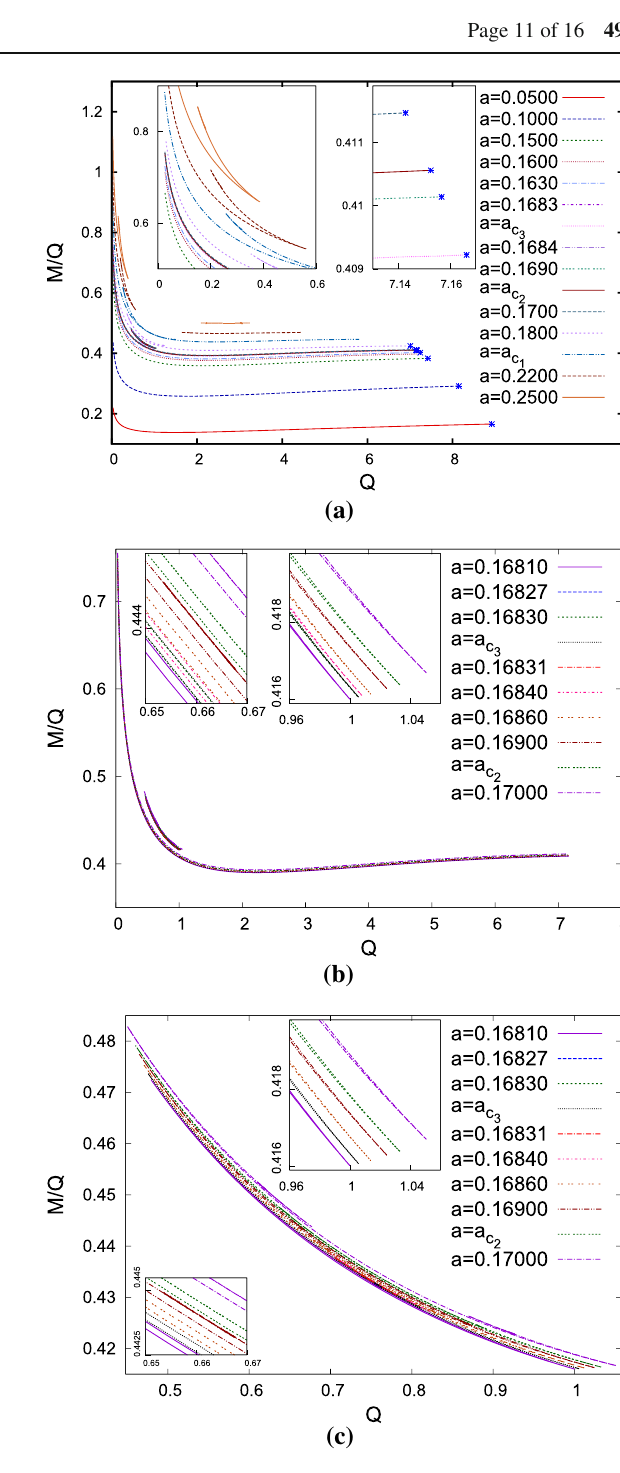
Fig. 7 a – c The mass M versus the charge Q for the same set of solu- tions. The asterisks represent the transition points from the boson stars to boson shells, and the inset magnifies a part of the diagram diagram, this behavior translates into a sequence of spikes, as seen in the insets of Figs. 7a and 8a. In this case the solu- tions should only be stable along their fundamental branch, which ends when a first spike is encountered at a maximal